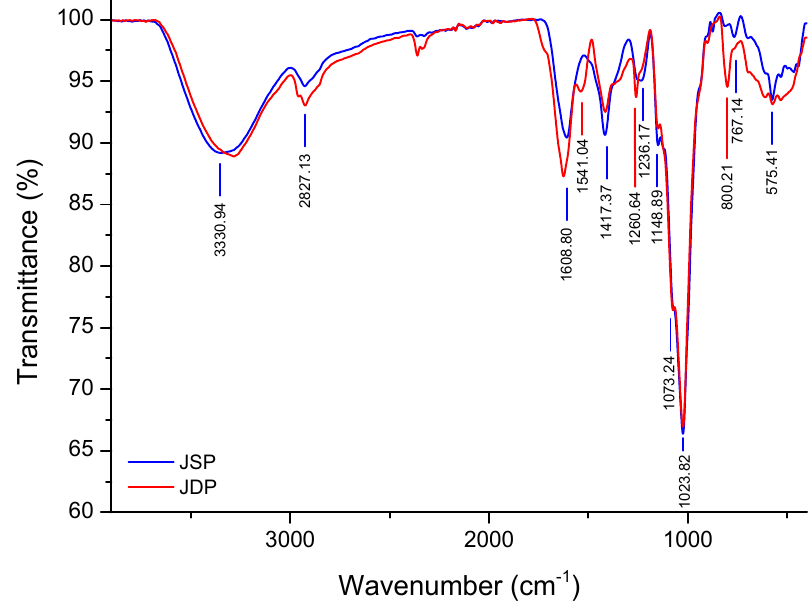
Figure 1. FTIR spectra of JSP (original sulfated fraction, in blue) and JDP (desulfated fraction, in